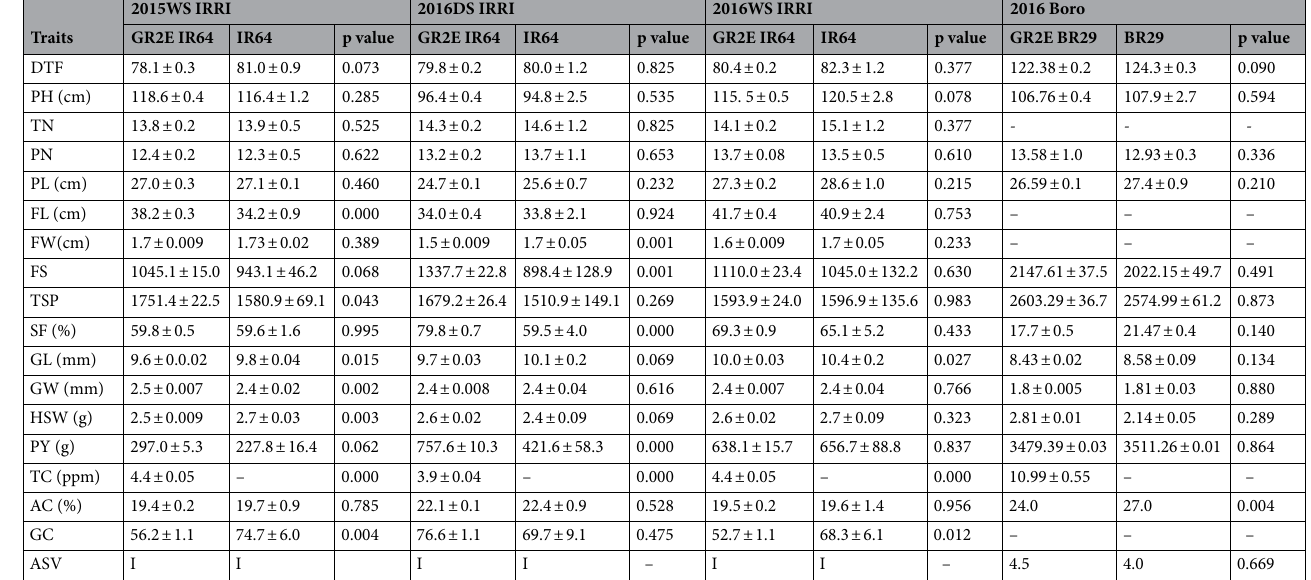
Table 3. Agronomic performance of GR2EIR64 at IRRI and GREBR29 at BRRI. DTF days to fifty percent flowering, PH plant height, TN Tiller number, PN Panicle number, PL Panicle length, FL flag leaf length, FW flag leaf width, FS number of filled spikelets, TSP total number of spikelets per plant, SF spikelet fertility, GL grain length, GW grain width, HSW hundred seed weight, PY plot yield, TC total carotenoids, AC amylose content, GC gel consistency, ASV alkali spreading value.